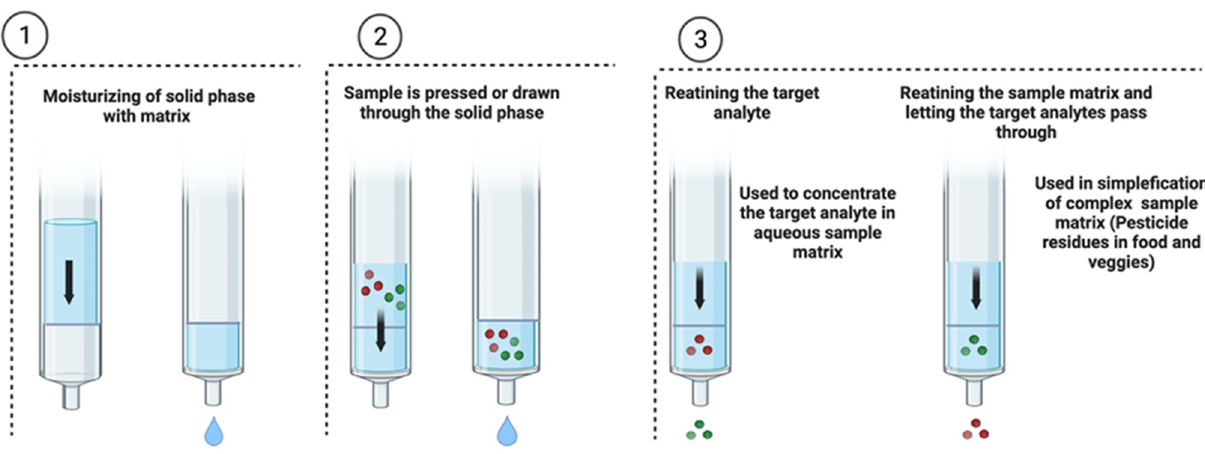
Figure 2. Solid-phase extraction procedures for the pesticide residue analysis in fruits and vegeta- bles.